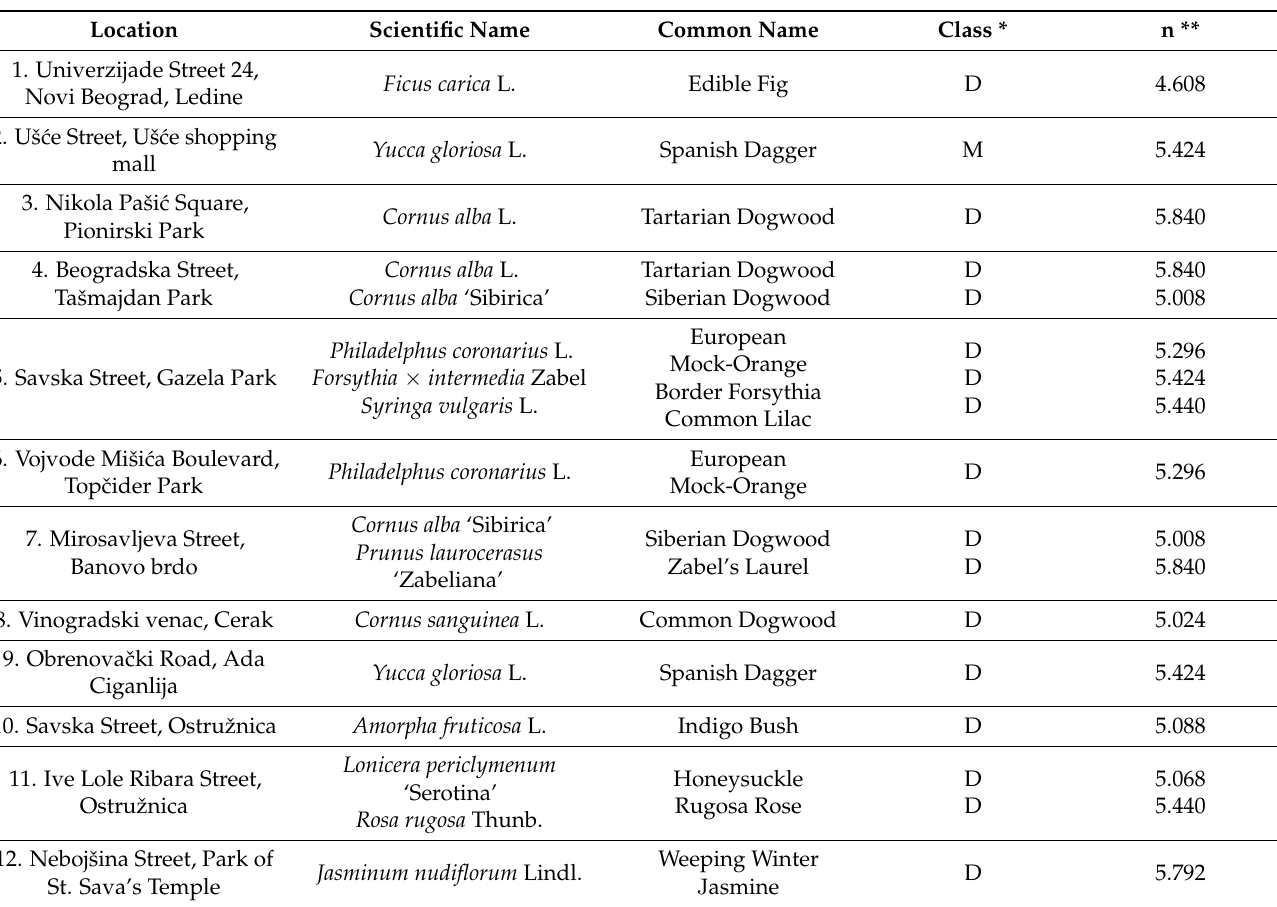
Table 1. Plants considered in the